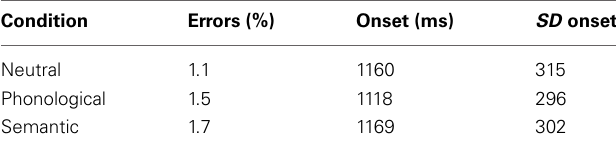
Table 1 | Number of errors and mean speech